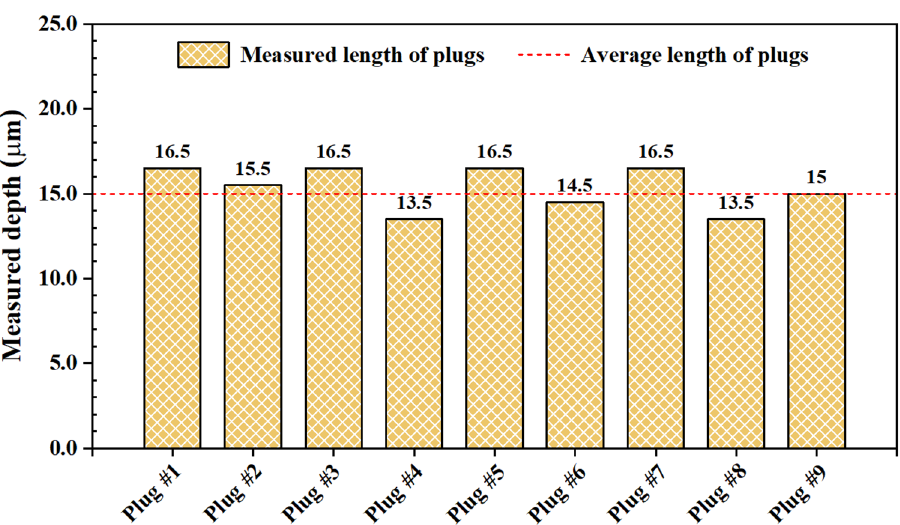
Figure 5. The quantitative measurements of representative plugs from the penetrated tubules by applying the test toothpaste. The average length calculated is 15.3